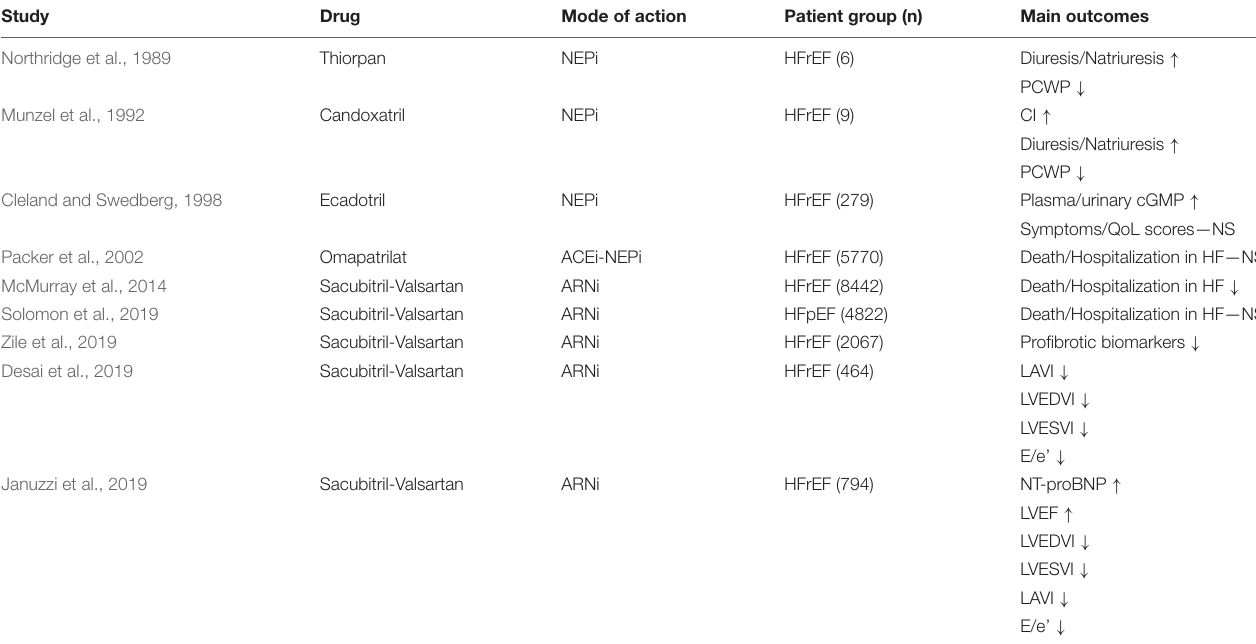
TABLE 2 | Clinical trials—inhibition of NP degradation in